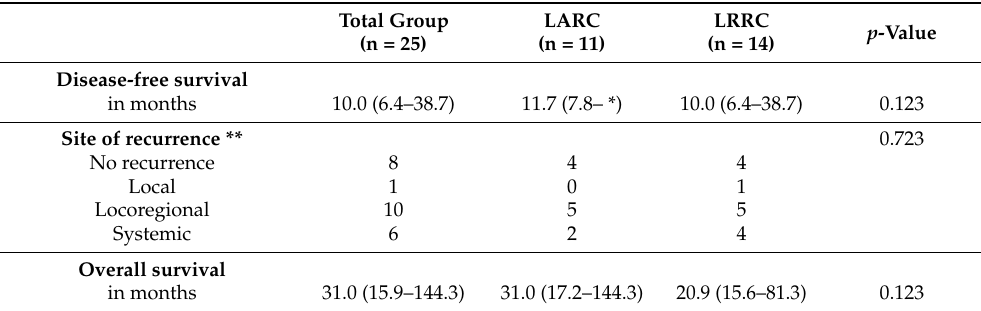
Table 4. Outcome measures of